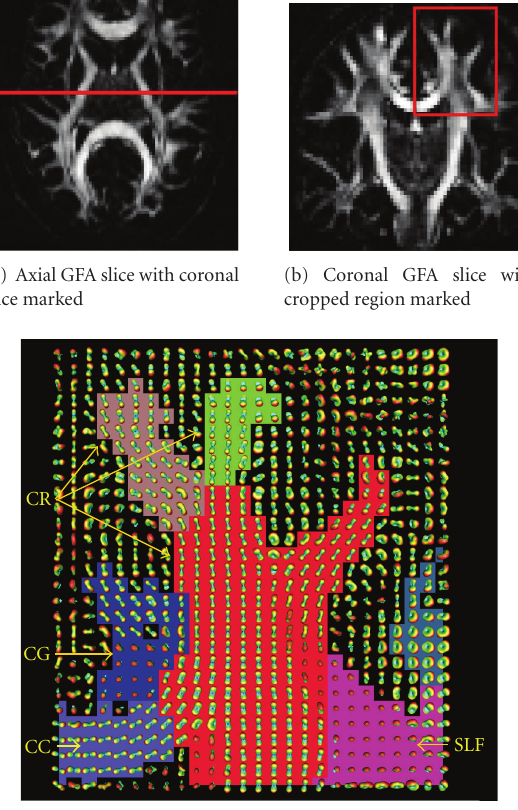
Figure 9: Our proposed algorithm is able to identify impor- tant white matter fiber bundles on a coronal slice of a real dataset. Generalized fractional anisotropy axial, Figure 9(a), and coronal, Figure 9(b) slices are shown. Labeled ODF visualization, Figure 9(c), each color represents one of the 7 clusters found. The white matter labels are CC: Corpus Callosum, CG: Cingulum, CR: Corona Radiata, SLF: Superior Longitudinal